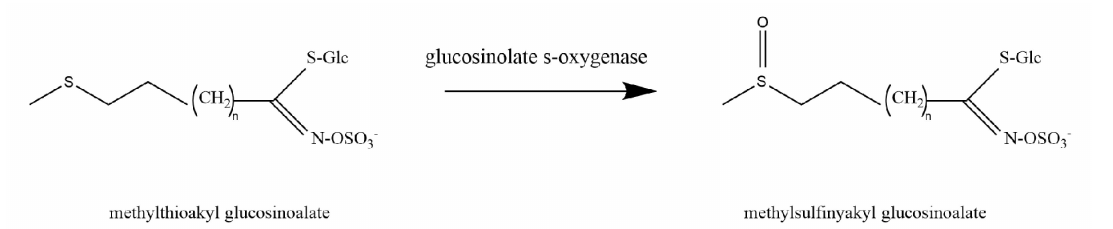
Figure 8. Enzymatic reactions catalyzed by flavin monooxygenase glucosinolate s-oxygenase enzymes (FMO GS-OX) in A.